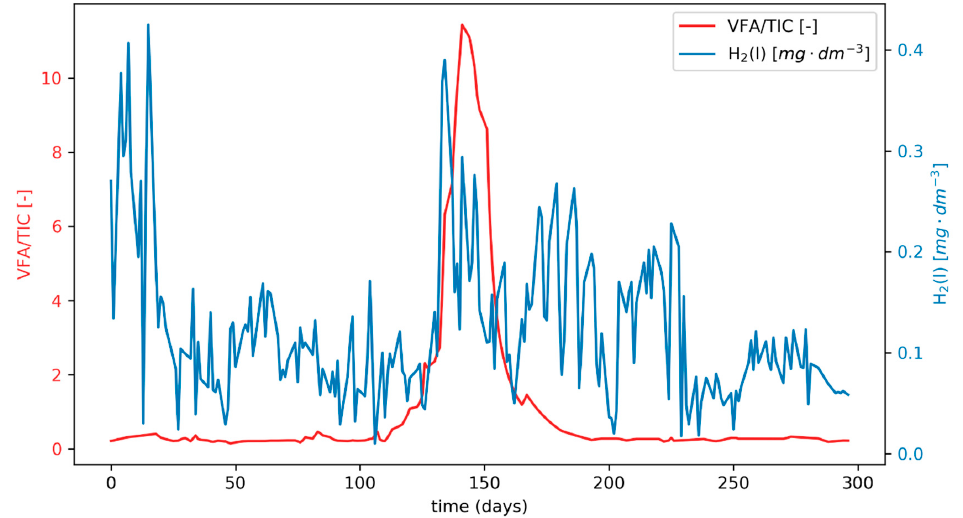
Figure 7. Dissolved H 2 versus VFA/TIC